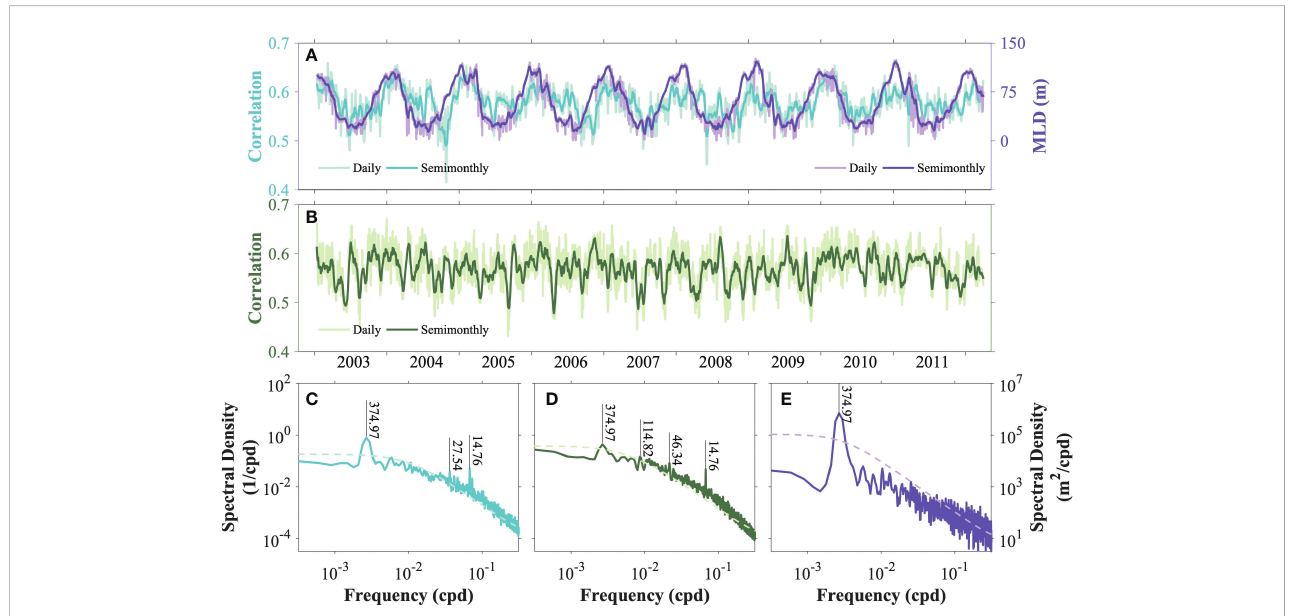
FIGURE 5 (A) Time series of the spatial correlation coef fi cient between Rossby number and strain rate (cyan lines) on the continental slope, and (B) those in the lee area of the Tokara Strait. Time series of mixed-layer depth (purple lines) in the continental slope, de fi ned as the depth with the strongest strati fi cation, were superimposed in (A) . The thin lines in lighter colors indicated daily results, while the thick lines in deeper colors were semimonthly smoothed. Frequency spectra of (C) spatial correlation time series in (A) , (D) mixed-layer depth time series in (A) , and (E) spatial correlation time series in (B) . The dashed lines represented a 95% signi fi cance level estimated by the red noise spectrum. Major spectral peaks were marked by corresponding periods